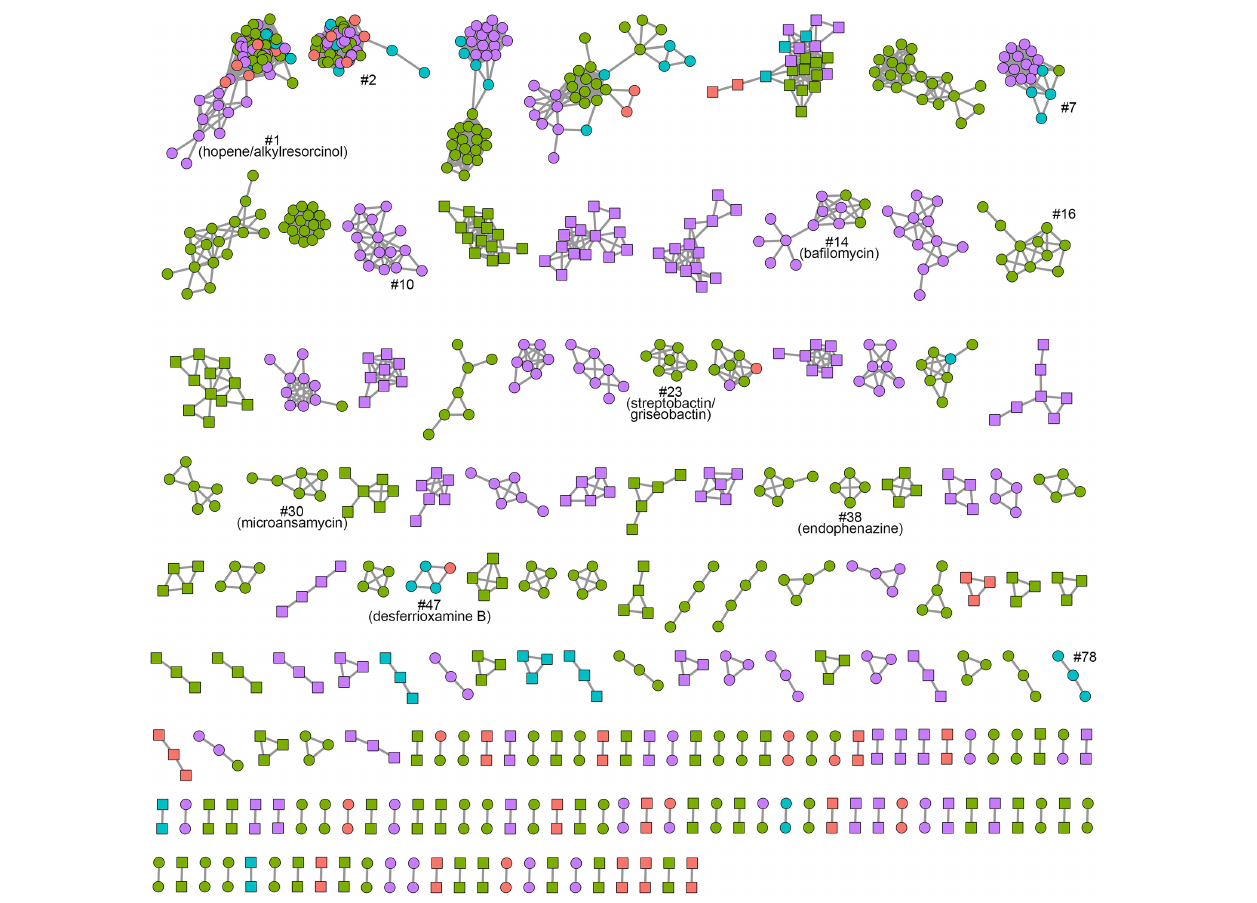
FIGURE 6 | BiG-SCAPE sequence similarity network of Kitasatospora . Each node represents one BGC identified by antiSMASH. Colors represent lineages I to IV (red, Lineage I; green, Lineage II; cyan, Lineage III; purple, Lineage IV). Kitasatospora -specific BGCs are highlighted with square node. BGCs discussed in this work are